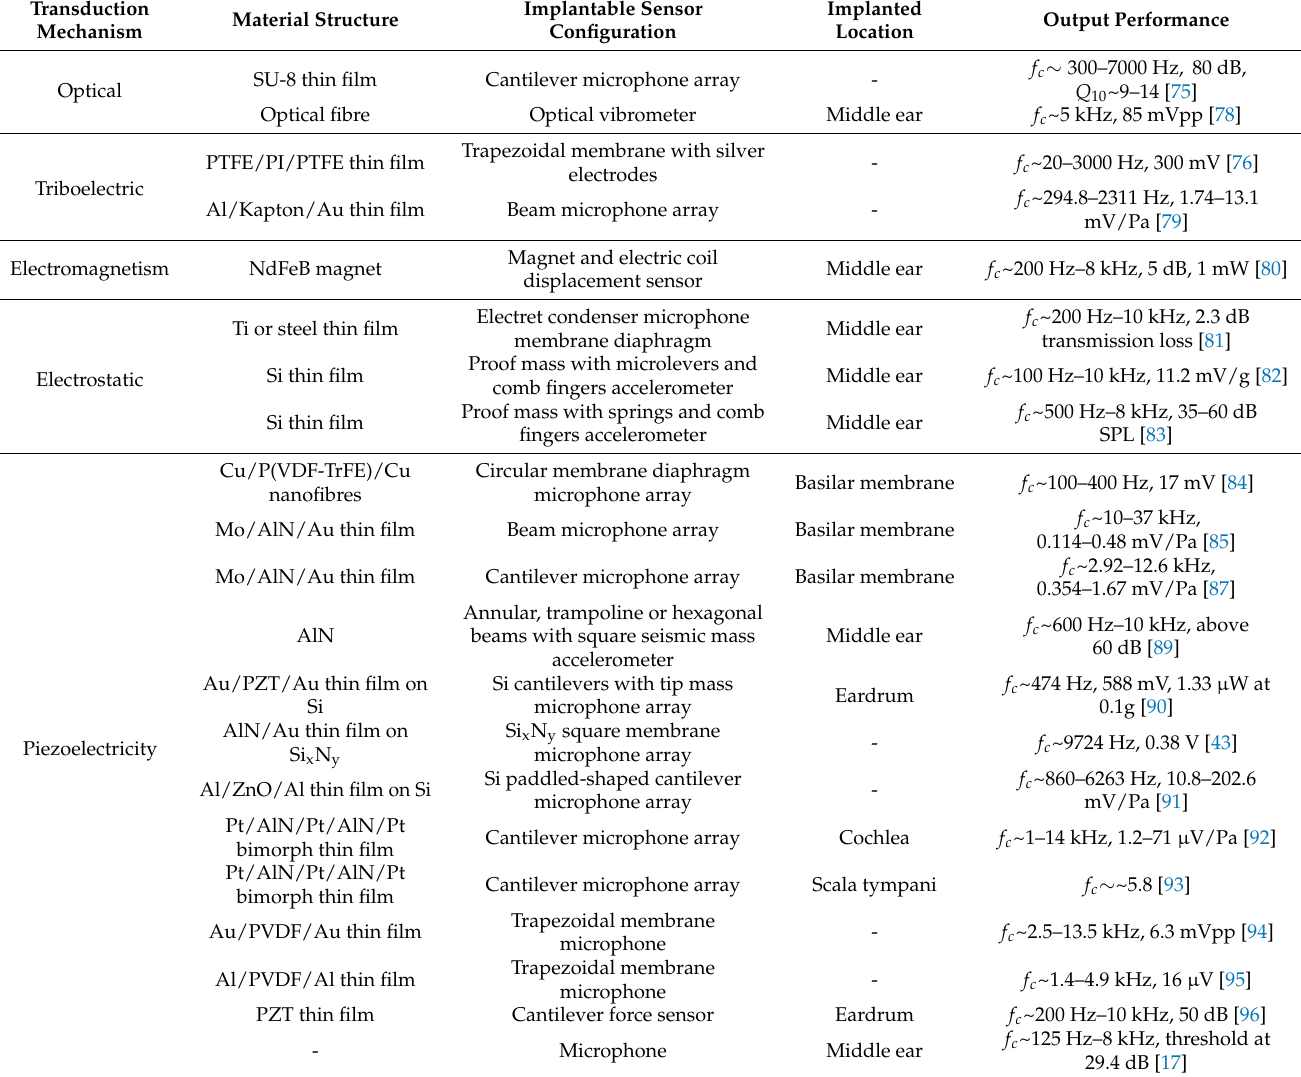
Table 4. Implantable sensor for totally implanted cochlear